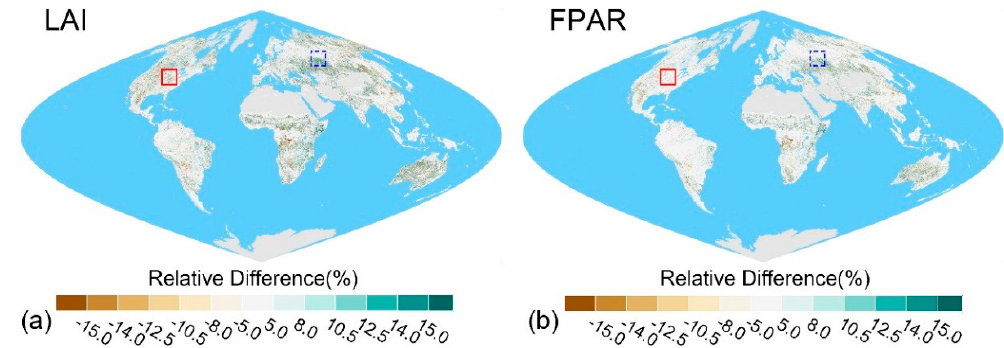
Figure 7. Spatial distribution of relative difference (100 × (C6-C5)/C5) for pixels with the same biome types (BTDF = 0) during 12th July to 19th July in 2003. ( a ) LAI; ( b ) FPAR. Detailed results from two tiles (h11v04 and h22v03) shown as red and blue boxes are given in Figure 8.